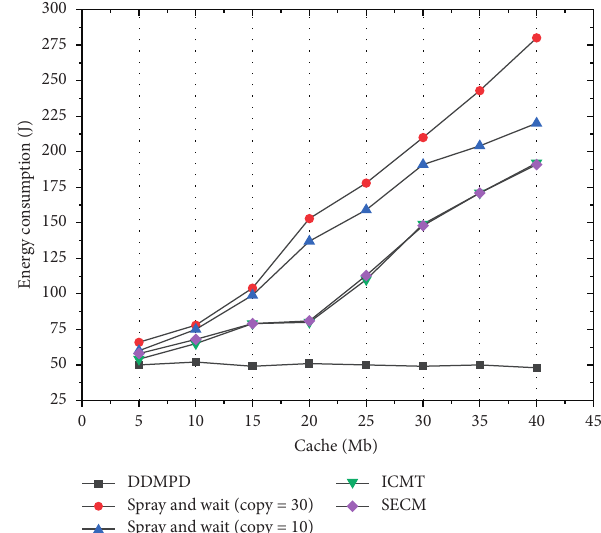
Figure 13: Relationship between energy consumption and cache.